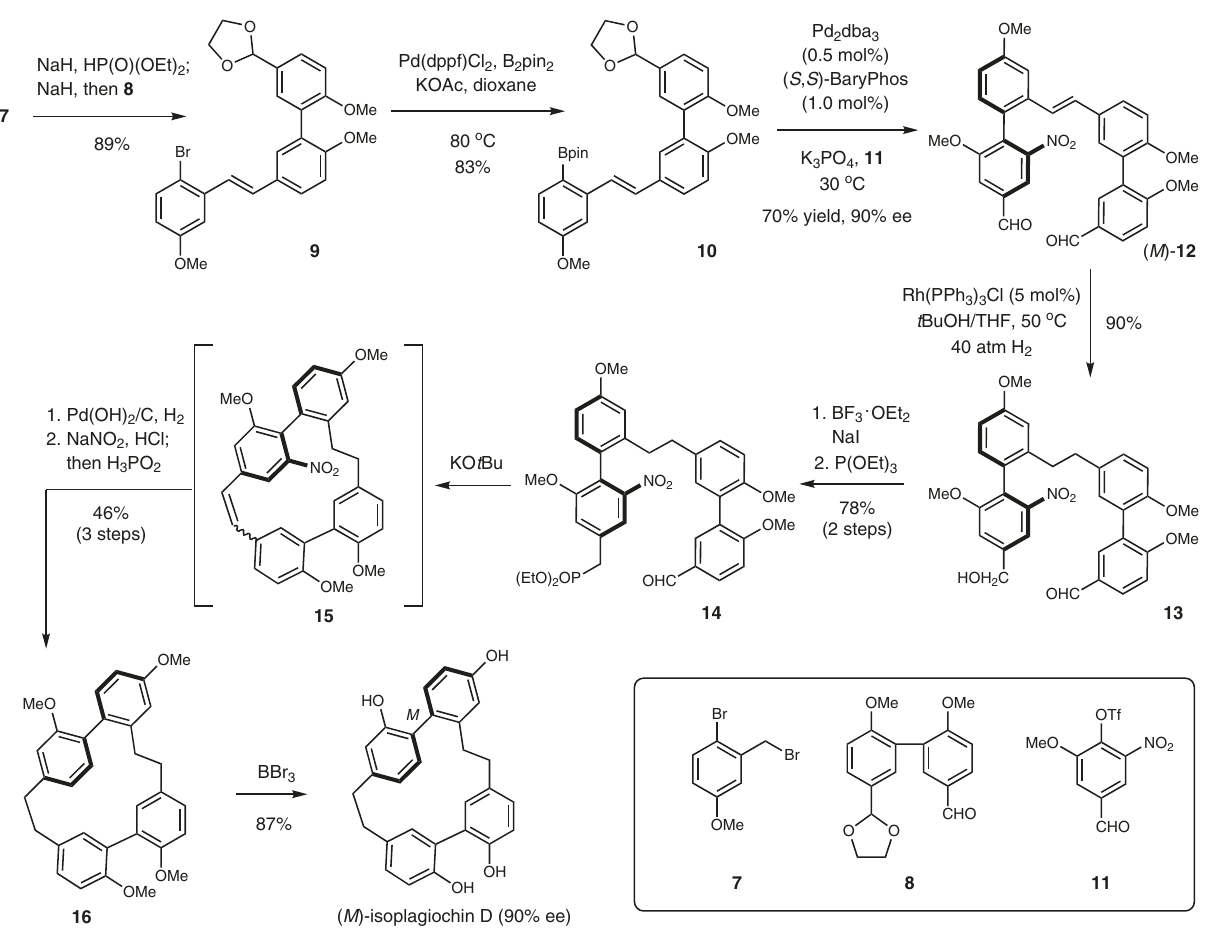
Fig. 6 | Enantioselective synthesis of isoplagiochin D. 10-step synthesis of ( M )-isoplagiochin D; detailed experimental information was provided in the Supplemen- tary Fig.